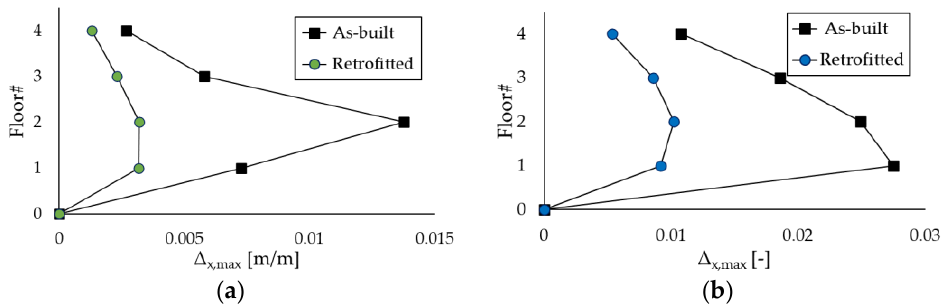
Figure 15. Maximum inter-story drift ratio Δ in the X-direction obtained by NLDAs: ( a ) RC structure, and ( b ) steel MRF.